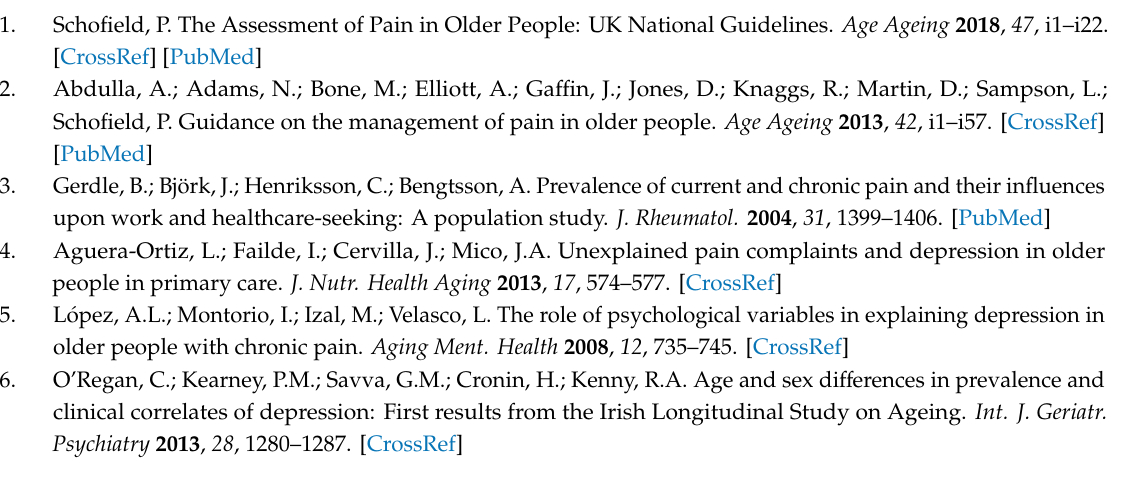
Table S1: Correlation of psychometric scales, Table S2: Indirect e ff ects upon pain catastrophizing (PCS), Figure S1: The mahalanobis distance (MD) for all